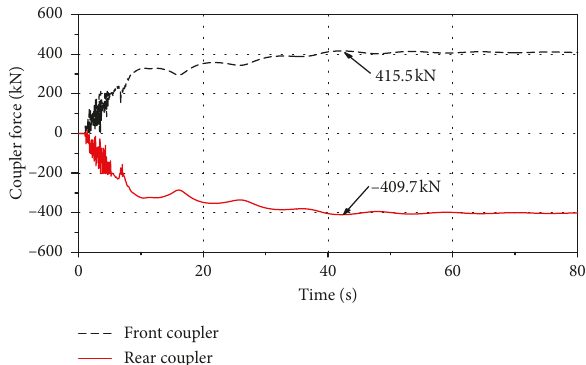
Figure 10: The simulated coupler forces for